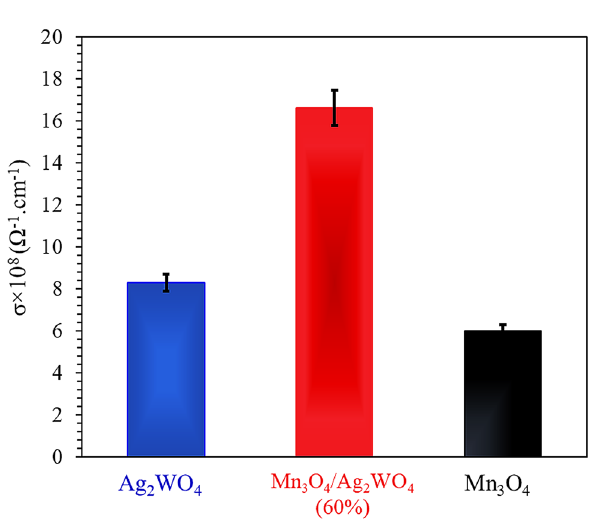
Figure 5. Conductivity measurements of α-Ag 2 WO 4 , Mn 3 O 4 and Mn 3 O 4 /α-Ag 2 WO 4 (60%)